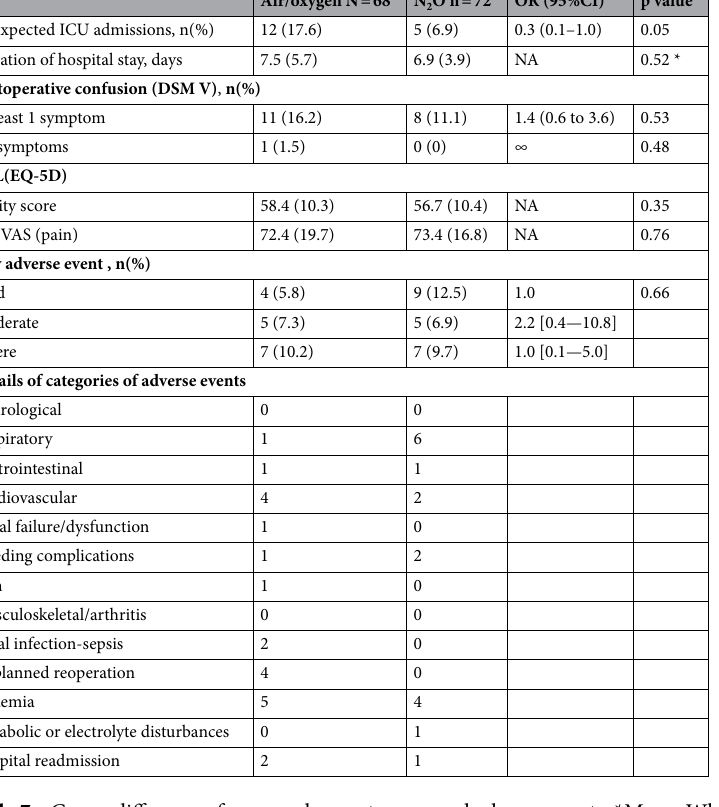
Table 7. Group differences for secondary outcomes and adverse events. *Mann-Whitney U test for comparisons of means (non parametric) and Chi-2 test (or Fisher exact test) for comparisons of